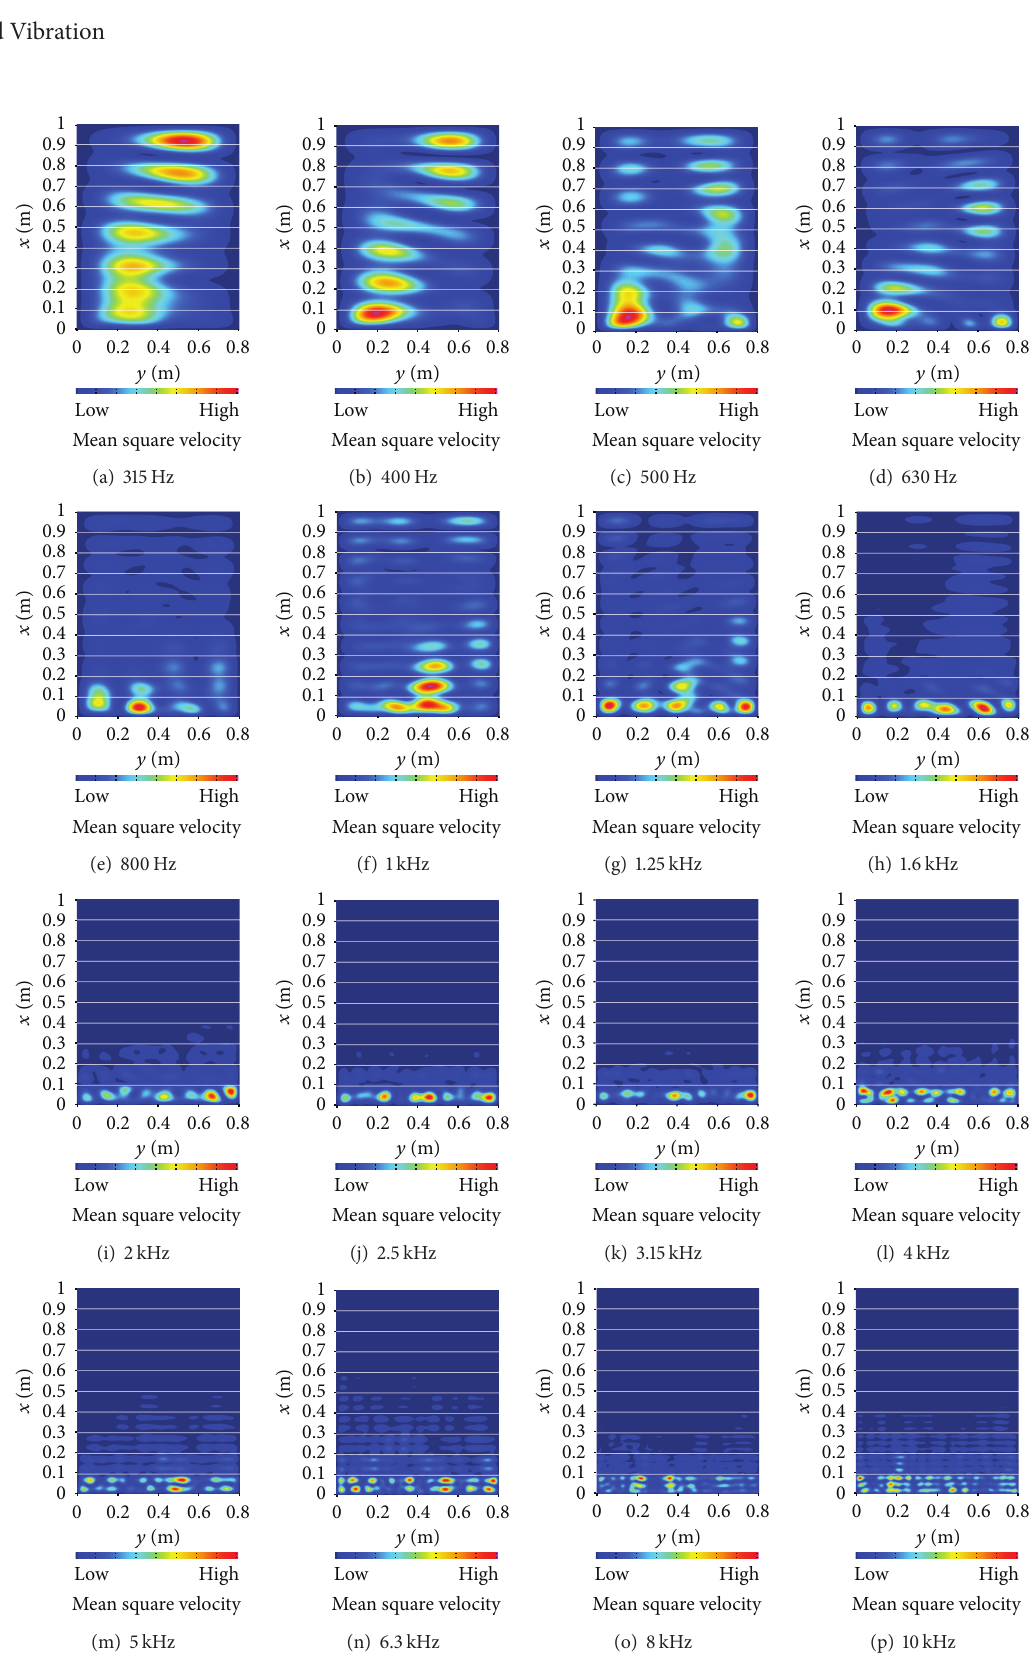
Figure 6: L-junction A. Mean-square vibration over the surface of the periodic ribbed plate (Plate 2) in one-third octave bands between 315 Hz and 10kHz with excitation on Plate